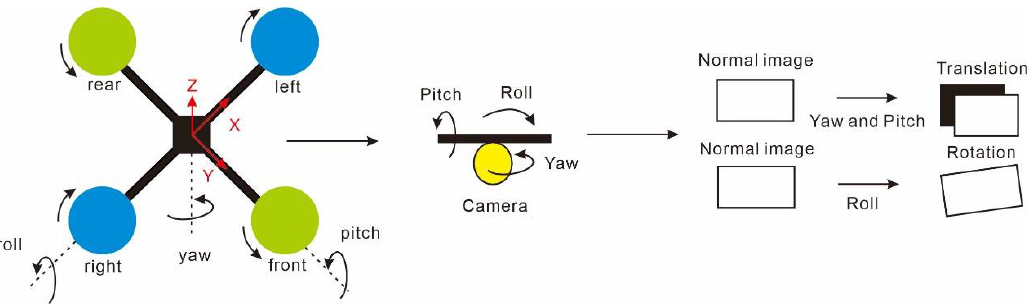
Figure 5. UAV movement modeling [25].